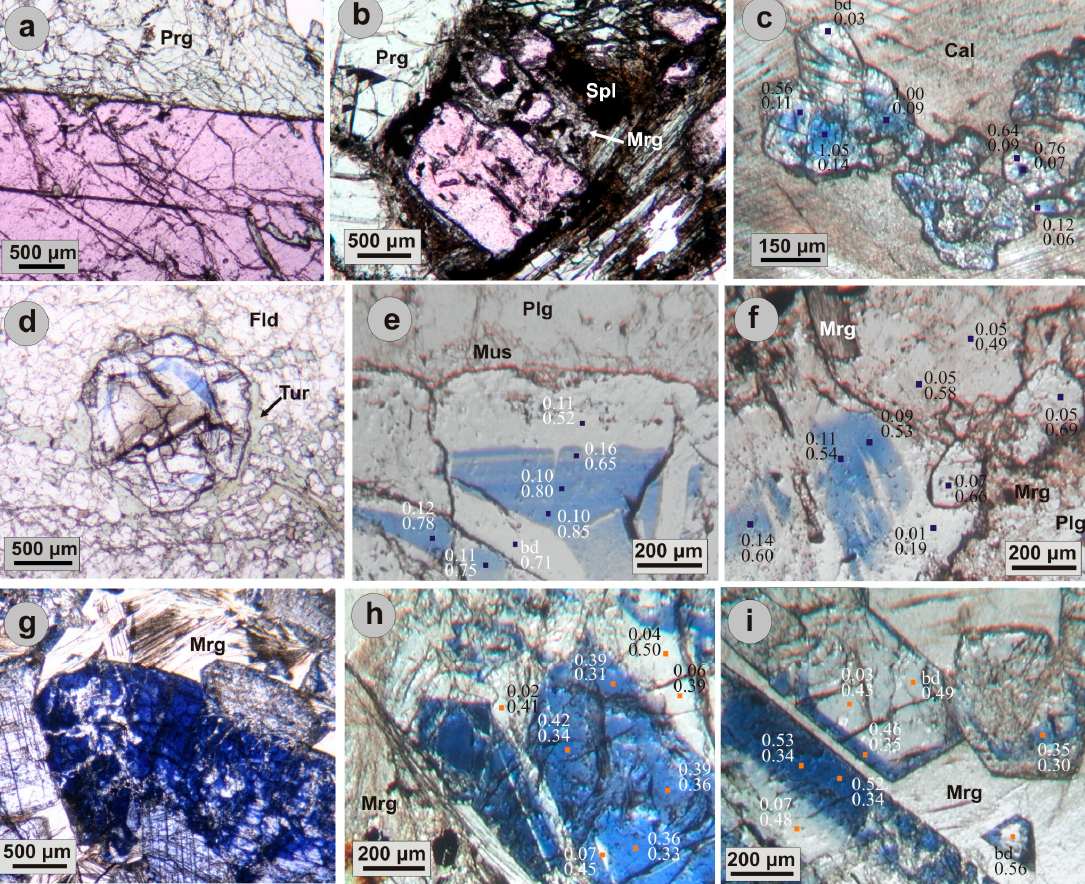
Figure 4. Microphotographs (plane polarized light) demonstrating mineralogical assemblages, color- and chemical zoning of corundum-bearing assemblages from Greece. Values in microphotographs ( c , e , f , h , i ) correspond to TiO 2 and Fe 2 O 3 content in wt. % (upper and lower values, respectively) as obtained by electron probe microanalyses. ( a , b ) Ruby associated with pargasite (Prg) from Paranesti, Drama area. Note replacement of ruby by spinel (Spl) and margarite (Mrg) in Figure 4b (sample Dr1a); ( c ) blue to colorless sapphires included in calcite, Xanthi area (sample Go1b); ( d , e ) Zoned blue to colorless sapphires within anorthite (Plg) and rimmed by tourmaline (Tur) and muscovite (Mus), Kinidaros, Naxos island (sample Nx4); ( f ) Sapphire with blue core and colorless rim associated with margarite (Mrg) and anorthite (Plg), Kinidaros, Naxos island (sample Nx3); ( g ) Idiomorphic deep blue colored sapphire crystals surrounded by margarite, Ikaria island (sample Ik1b); ( h , i ) Zoned blue to colorless idiomorphic sapphires, surrounded by margarite, Ikaria island (sample Ik2) .